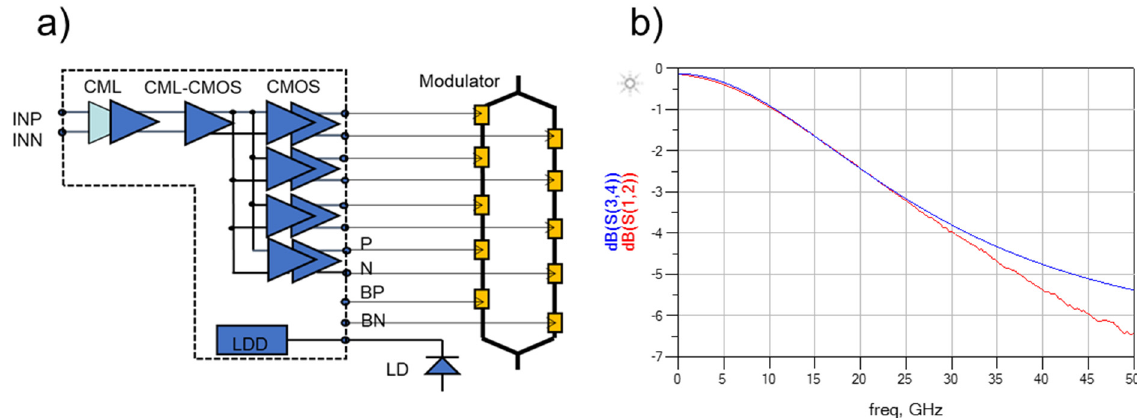
Figure 11. Mach–Zehnder modulator (MZM) design and performance. ( a ) Schematic diagram of MZM driven by CMOS IC; ( b ) frequency characteristics of the MZM.